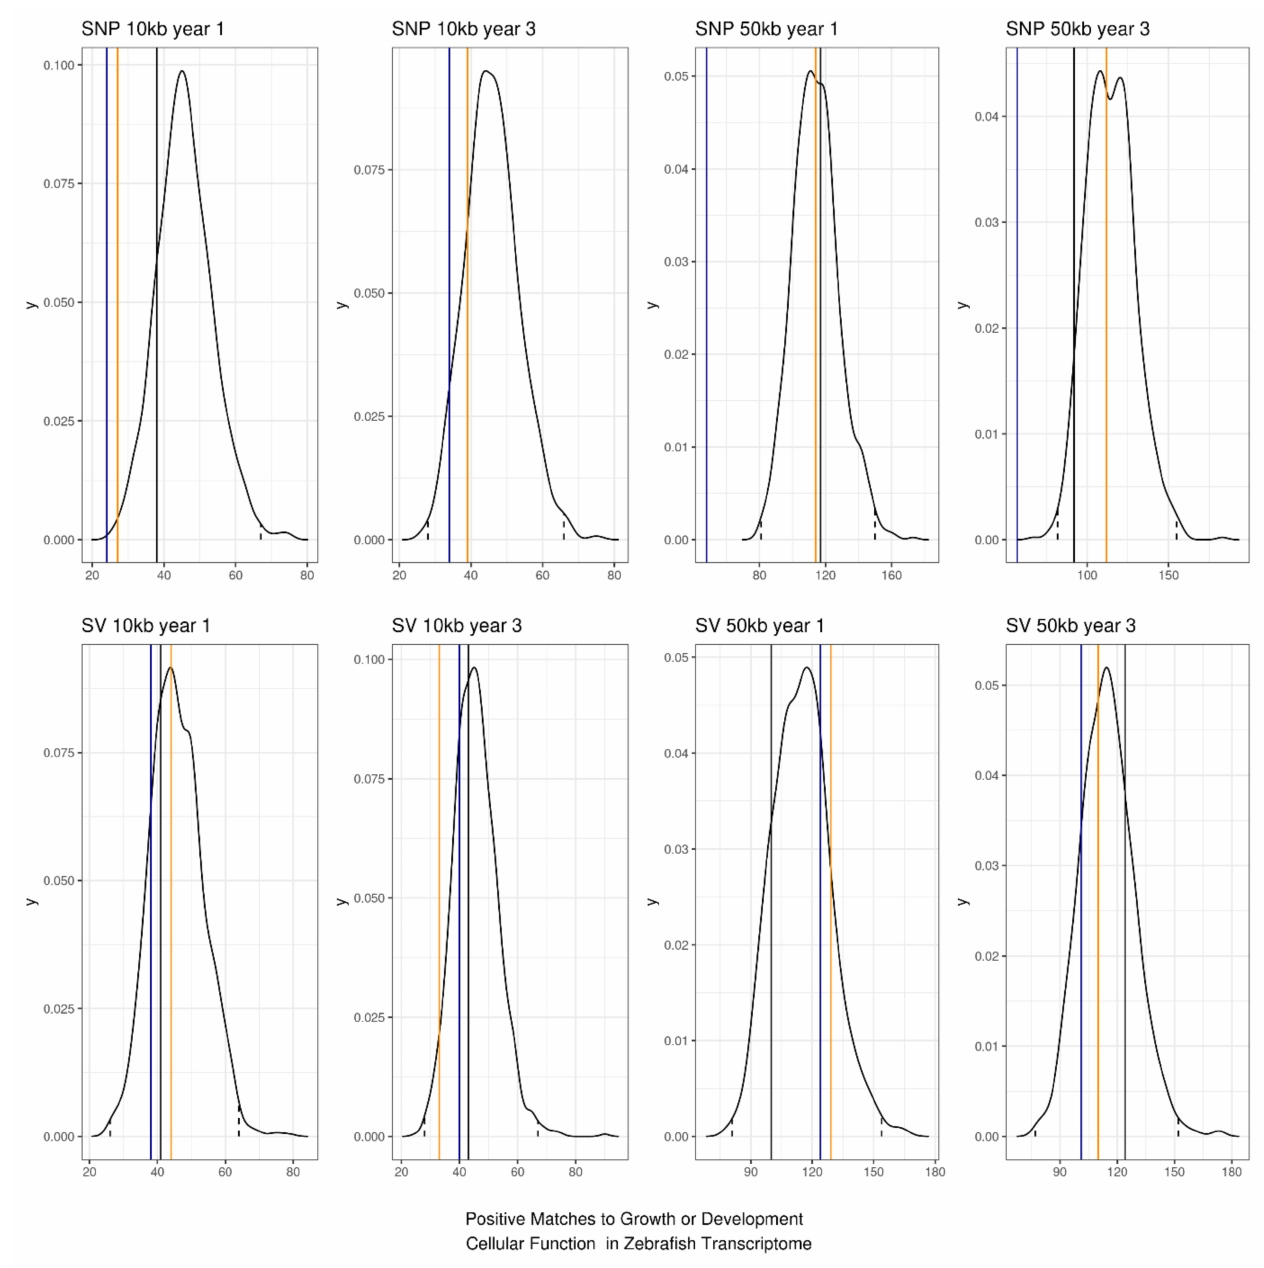
Figure 8. Permutation test of top 200 features compared to sampling 200 features randomly across the genomic windows. Solid lines are the number of positive hits to a genomic annotation of zebrafish that contain the words “Growth” or “Development” in the cellular function column (black is relief feature selection, blue is mutual information feature selection, and orange is Chi-square feature selection). Dotted lines are the 99% confidence intervals for the 1000 sets of 200 randomly sampled